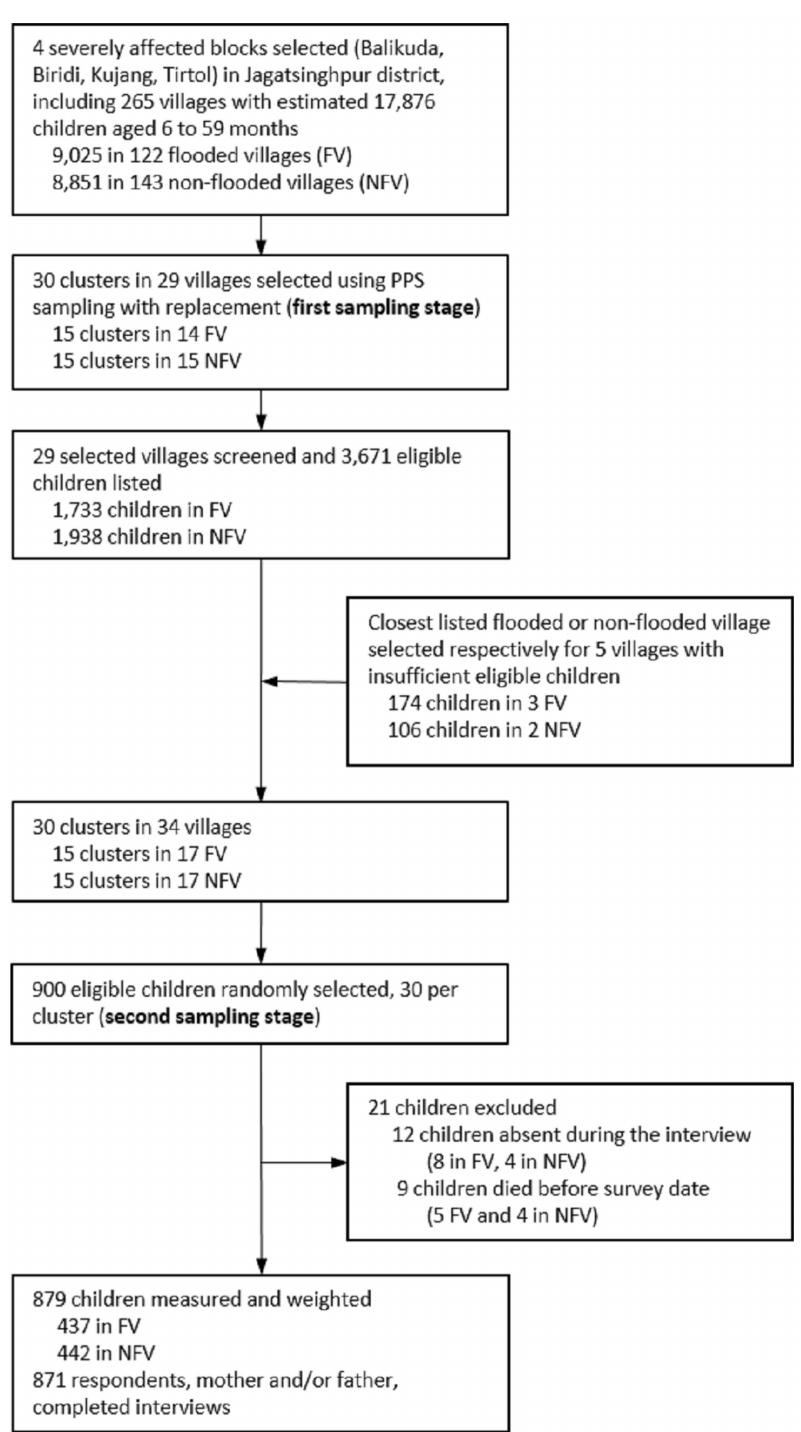
Figure 1. Flow diagram of sample